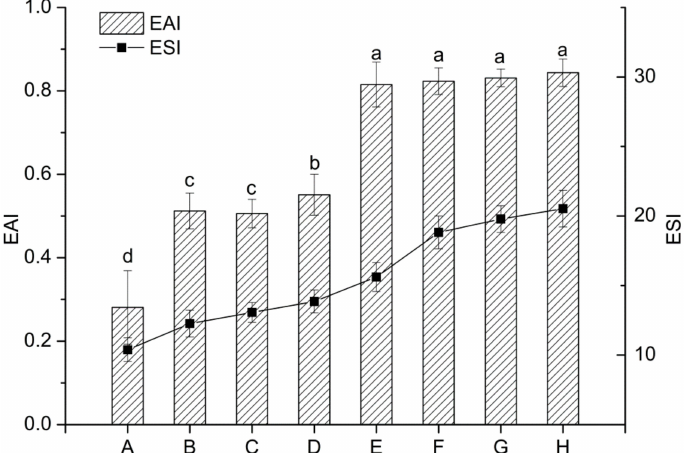
Figure S1: High performance liquid chromatography (HPLC) of IMO, Table S1: Composition of IMO determined by HPLC (Figure